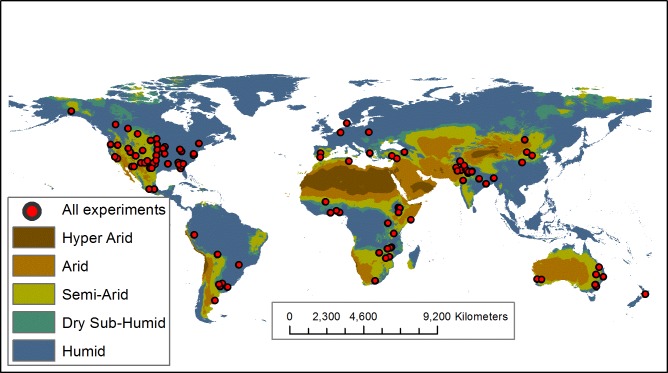
Map of experiment locations included in the analysis, with respect to their aridity regimes.Aridity regimes were determined using the aridity index, an integrated measure of temperature, precipitation and potential evapotranspiration from the CGIAR-CSI Global-Aridity and Global-PET Database [40,41]. Maps were generated with ESRI ArcGIS version 10.4 (http://www.esri.com). See Fig D in the S1 File for maps depicting locations for individual practices.